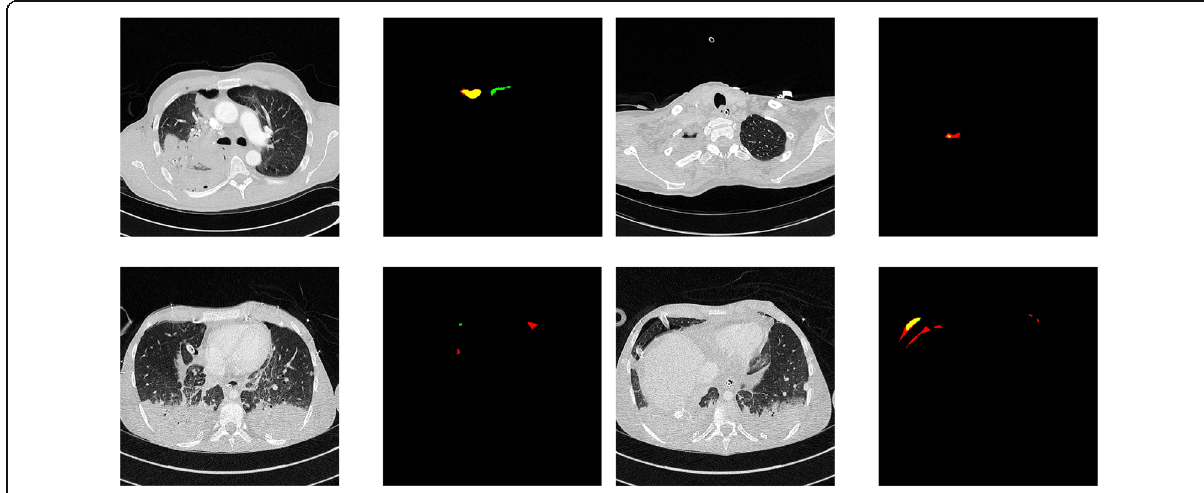
Fig. 5 Failure cases of segmentation results. Raw images and corresponding segmentation results. False-negatives (red), false-positive pneumothorax predictions (green), and correct pneumothorax predictions